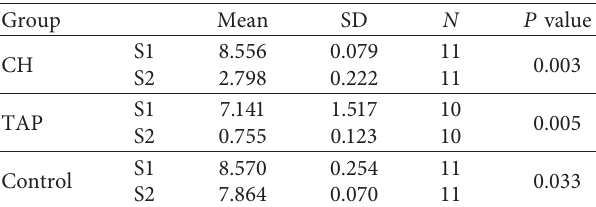
Table 2: Comparison of the log transformation of the bacterial counts between S1 and